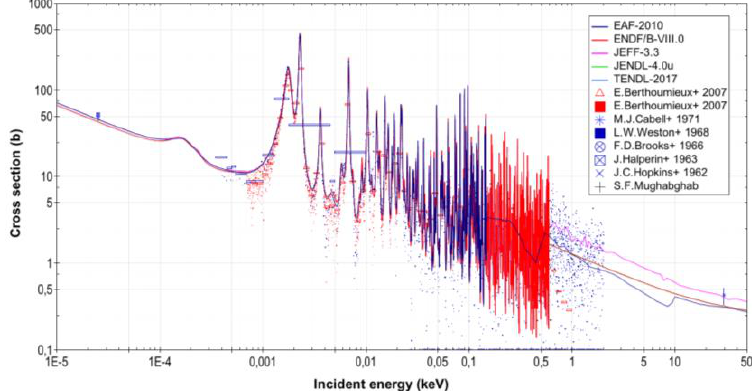
Fig. 1. Existing data sets and evaluations for the 233 U capture cross section.